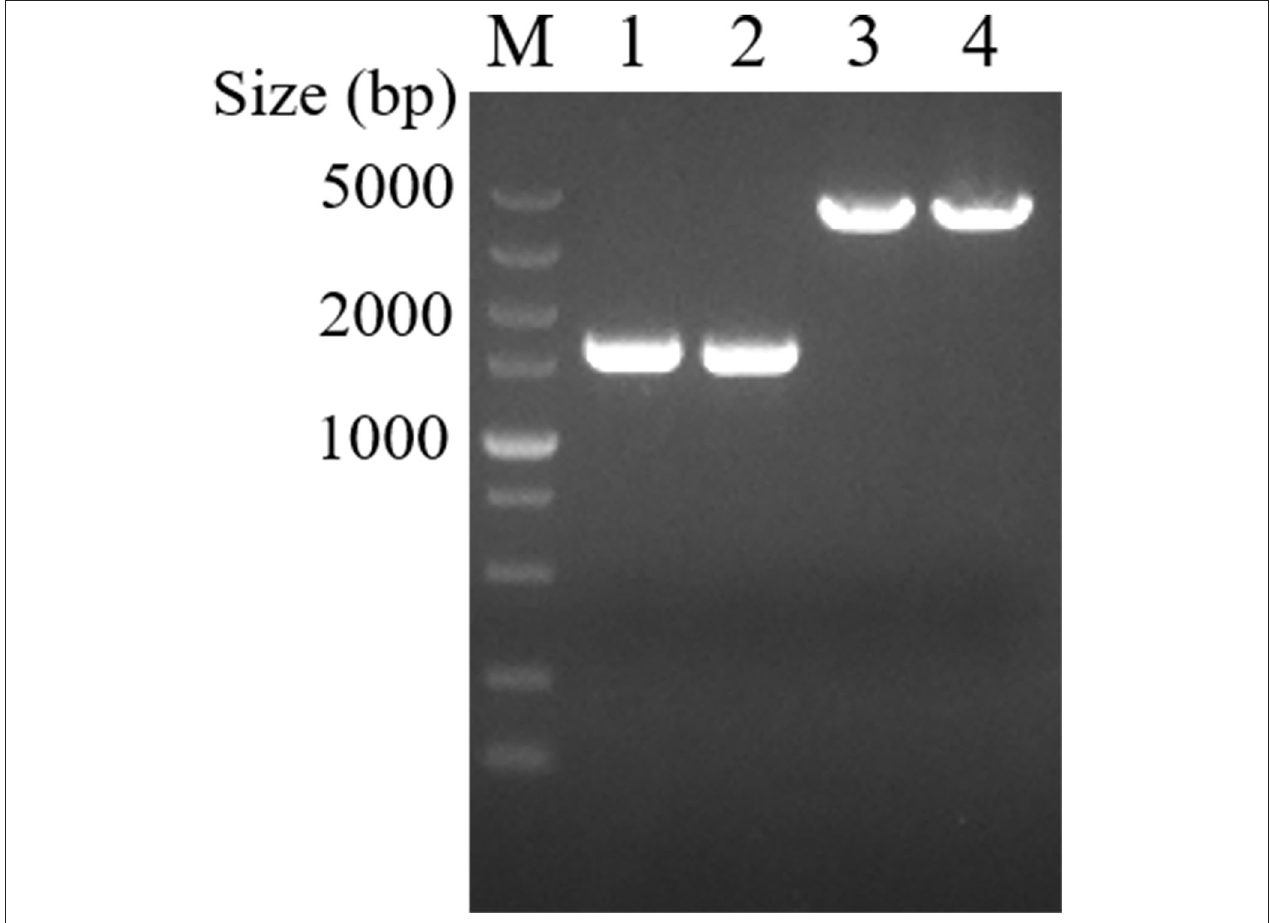
FIGURE 4 | Rescue of recombinant viruses rPRV-SARS-CoV-2-S and rPRV-SARS-CoV-2-N identified by PCR. Lanes 1 and 2 were recombinant viruses rPRV-SARS-CoV-2-N F5 and F10. Lanes 3 and 4 were recombinant viruses rPRV-SARS-CoV-2-S F5 and F10. M was DL5000 DNA Marker (Takara,